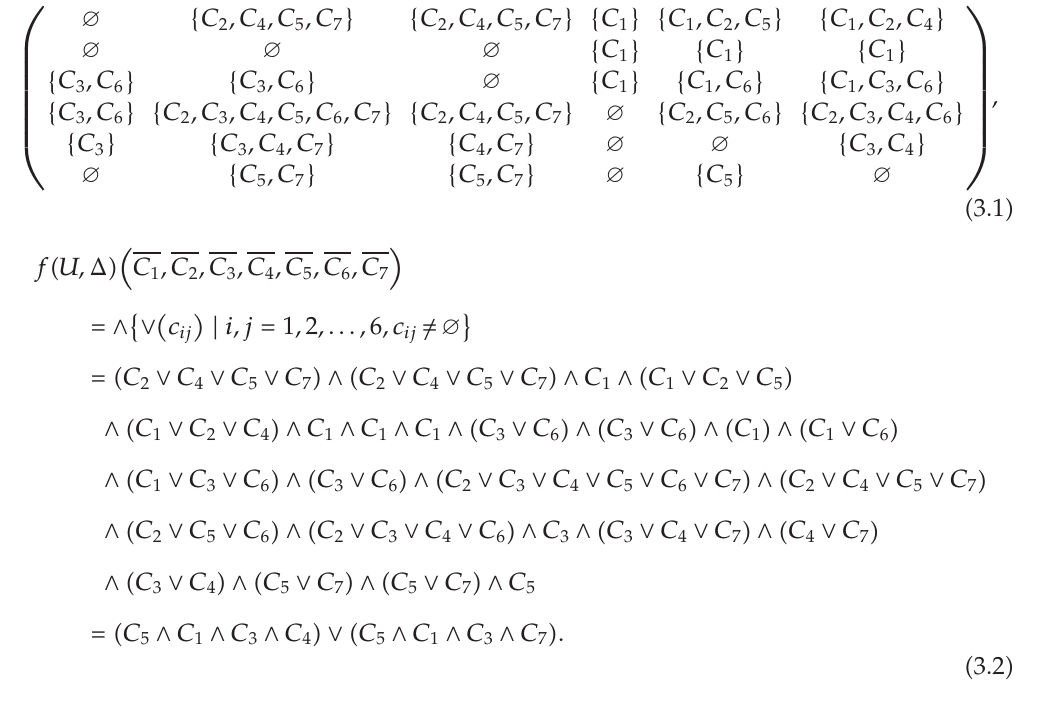
Table 1 can be simplified into Table 2 or Table 3, and the ability of classification is